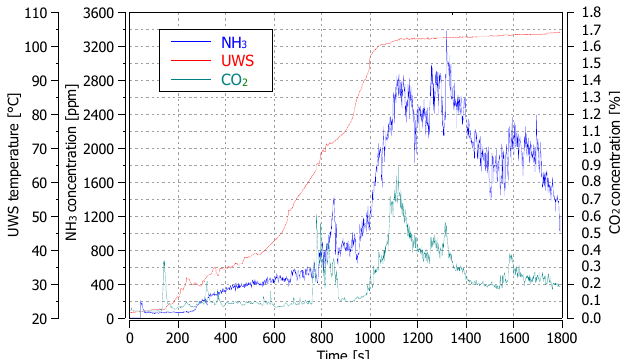
Figure 2. Results of NH 3 and CO 2 concentration measured over urea–water solution heat ‐ up.